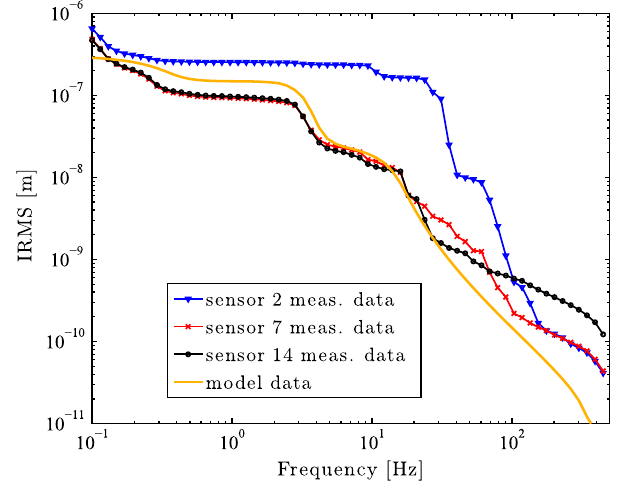
FIG. 10. Integrated root mean square motion (IRMS) of the ground motion sensor measurements and model data in vertical direction.